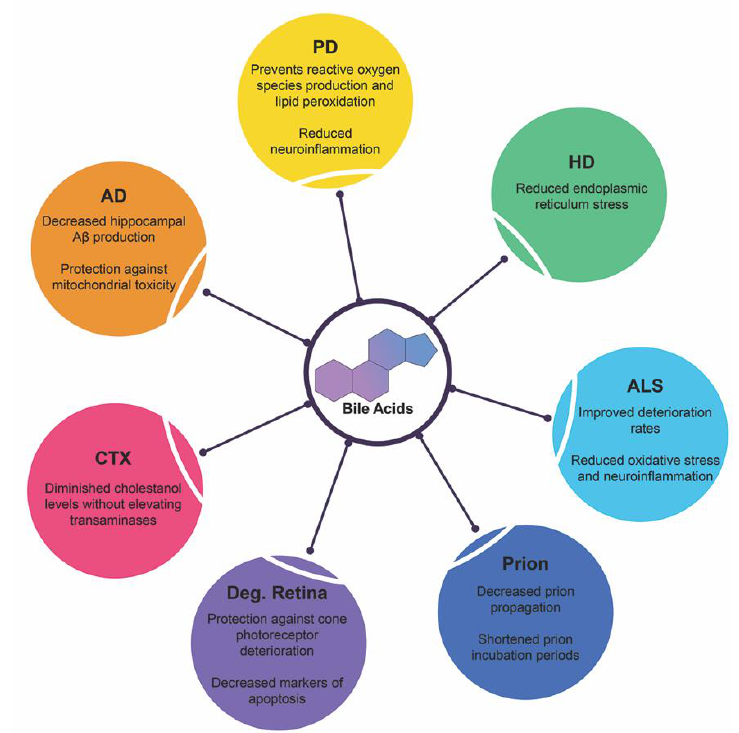
Figure 4. Neuroprotective functions of bile acids in neurodegenerative diseases. Recent clinical trials and experimental animal studies have shown the protective qualities of therapeutic bile acids in these disease states. Abbreviations: Alzheimer’s disease (AD), Parkinson’s disease (PD), Huntington’s disease (HD), amyotrophic lateral sclerosis (ALS), prion diseases (Prion), degenerative retina diseases (Deg. Retina), Cerebrotendinous xanthomatosis (CTX).